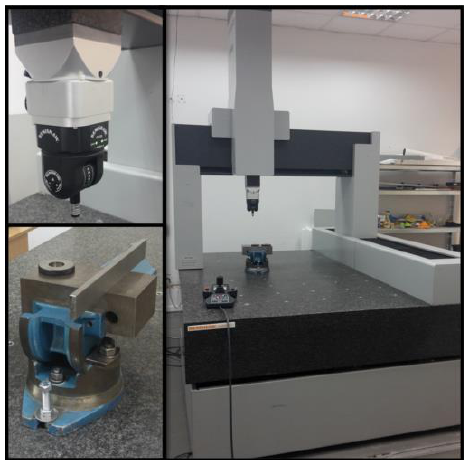
Figure 3. Photographs of the Zeiss WMM 850S (right side), the Renishaw PH20 measuring head (upper left), and the mounting of gauges during measurements (lower left).